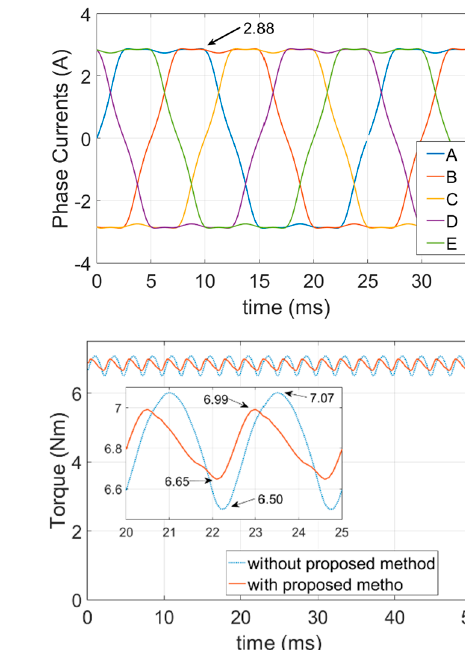
( b ) Figure 11. FEA torque waveforms for the Healthy2 condition with and without proposed method: ( a ) Only fundamental; ( b ) fundamental plus third harmonic.